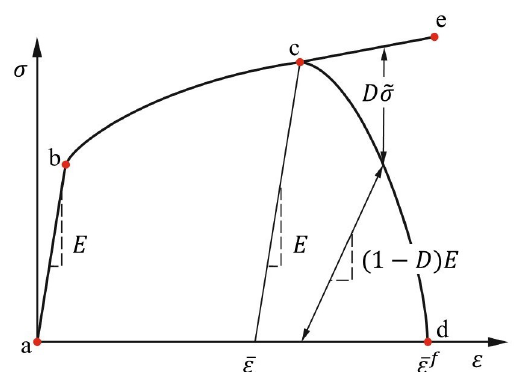
Figure 1. Uniaxial stress–strain response of an elastoplastic material as per